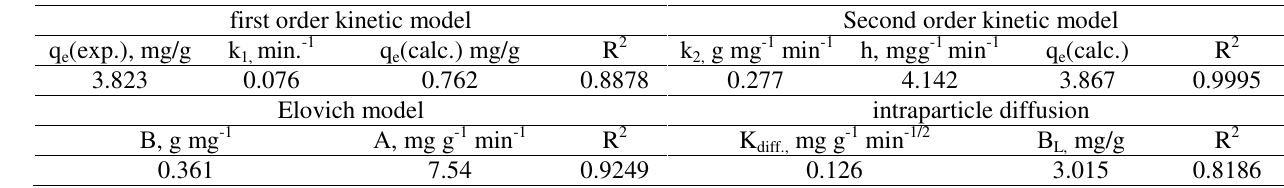
qmg -1 min -1 ) Equilibrium constant (K 2,